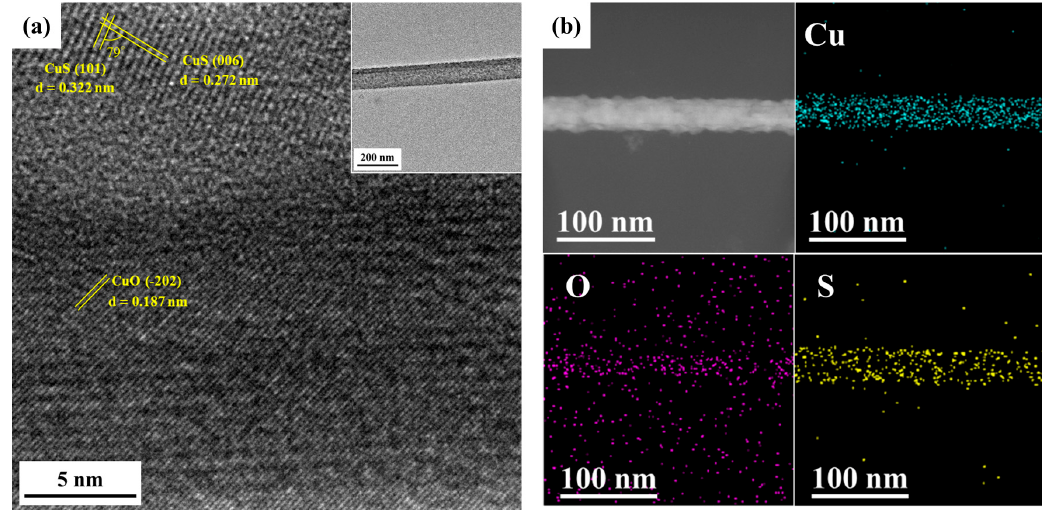
Figure 7. ( a ) TEM analysis and ( b ) EDS mapping of the CuO-CuS nanowire after 4 cycles of photocatalytic reactions